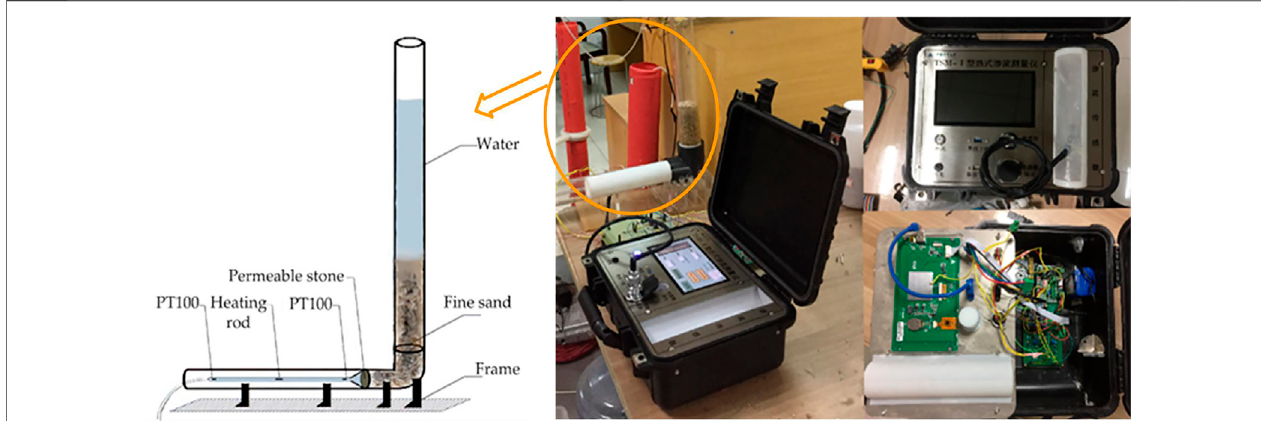
FIGURE 6 | The overall structure of the portable seepage